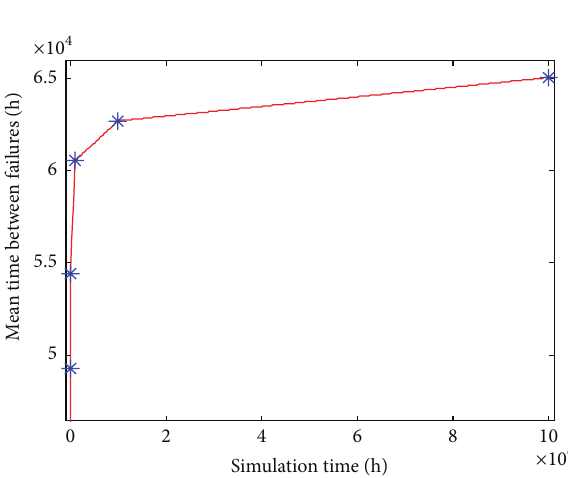
Figure 8: The relationship curve between mean time to restoration and simulation time.